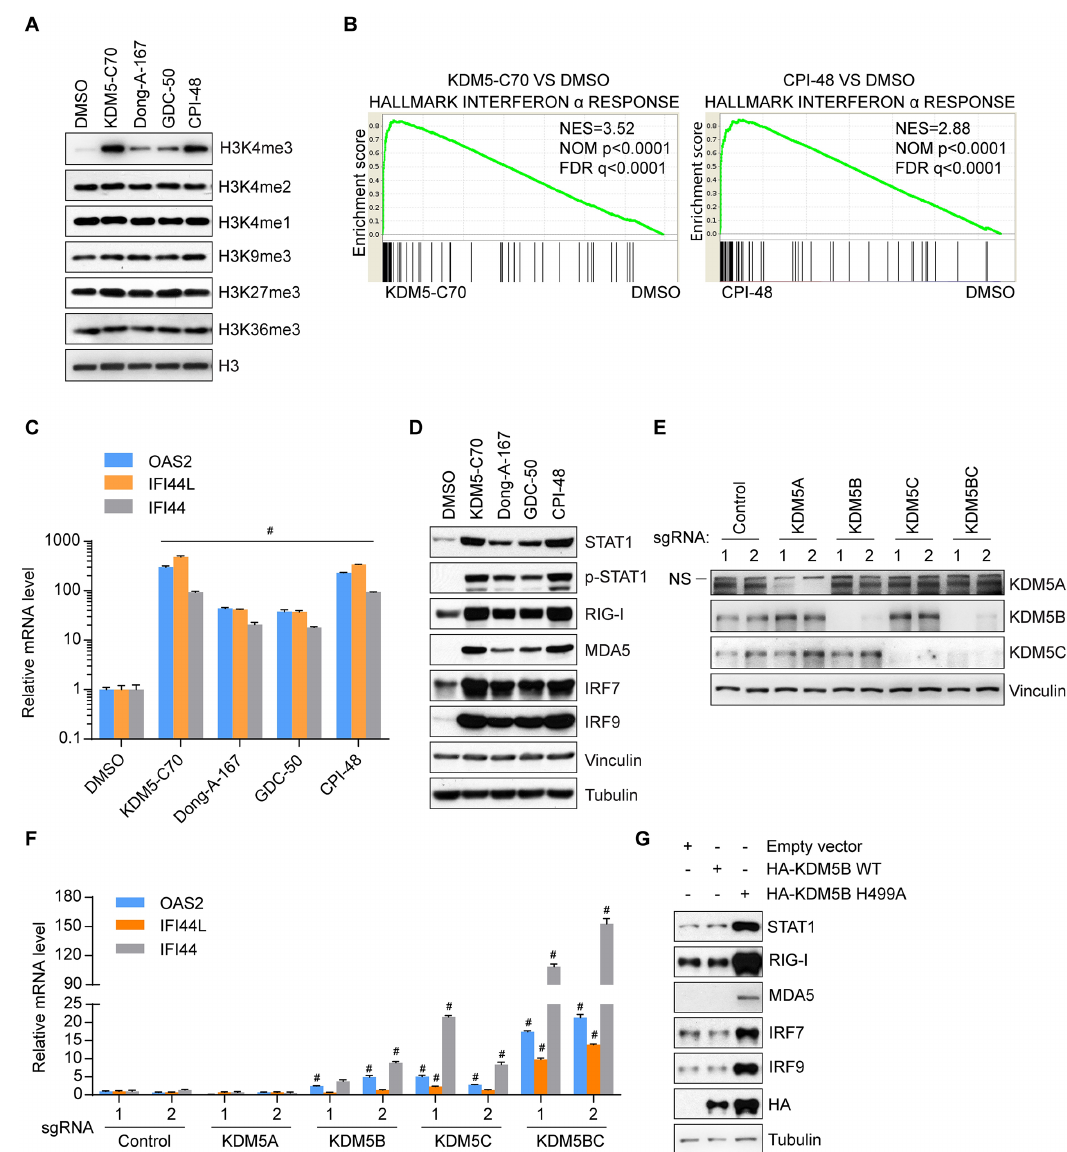
Fig 1. Inhibition of KDM5 demethylases activates interferon-induced genes. (A) Western blot analysis of histone modifications in MCF7 cells treated with 1 μM KDM5-C70, 10 μM Dong-A-167, 10 μM GDC-50, or 10 μM CPI-48 for 3 days. (B) GSEA of RNA-seq data from MCF7 cells treated with 3 μM KDM5-C70 or CPI-48 for 6 days. (C, D) RT-qPCR (panel C) and western blot (panel D) analyses of MCF7 cells treated with 1 μM KDM5-C70, 10 μM Dong-A-167, 10 μM GDC-50, or 10 μM CPI-48 for 6 days. (E, F) Western blot (panel E) and RT-qPCR (panel F) analyses of MCF7 cells with stable knockout of the indicated genes using the CRISPR/Cas9 system. Control 1, empty vector; control 2, scrambled sequence. KDM5BC, 2 sgRNAs targeting KDM5B and KDM5C. (G) Western blot analysis of MCF7 cells after transfection with indicated plasmids. Representative data from triplicate experiments are shown. Error bar denotes SEM. # p < 0.01 for inhibitors versus DMSO (panel C), and for knockout sgRNA versus average of 2 control sgRNAs (panel F). The numerical values used to generate graphs in panel C and F are available in S1 Data. CRSPR/Cas9, clustered regular interspaced short palindromic repeats/CRISPR-associated protein 9; FDR q, false discovery rate q value; GSEA, gene set enrichment analysis; NES, normalized enrichment score; NOM p, nominal p value; NS, nonspecific band; RNA-seq, RNA sequencing; RT-qPCR, reverse transcription followed by quantitative PCR; sgRNA, single guide RNA.